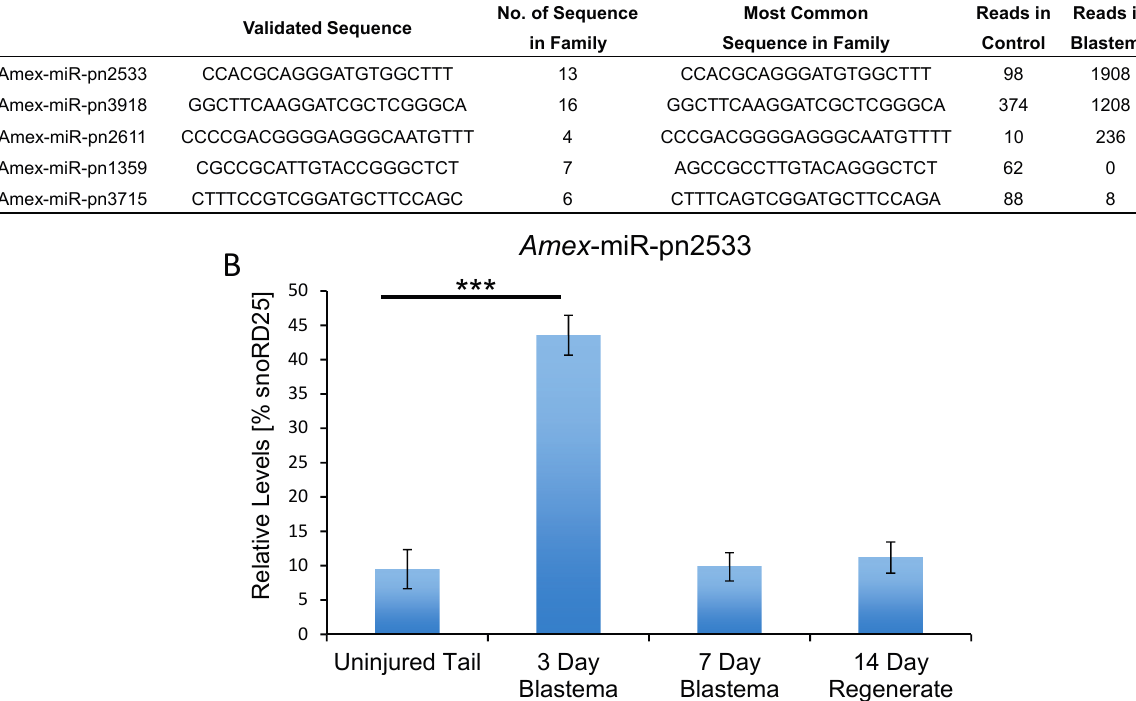
Figure 2. Identification of putative novel microRNAs in axolotl. ( A ) Table of putative novel microRNAs found in axolotl but not in other invertebrate or vertebrate species. The first three microRNAs are enriched in the blastema. The last two microRNAs listed are found in mature tissue but not at significant levels in the blastema. The table shows validated sequences, the number of sequences in the family and the number of reads found in the mature tissue versus the three-day blastema; and ( B ) Quantitative RT-PCR analysis confirmed the deep sequencing data that Amex -miR-pn2533 is upregulated in the 3 day blastema and returns to basal levels by seven days post injury ( *** p <